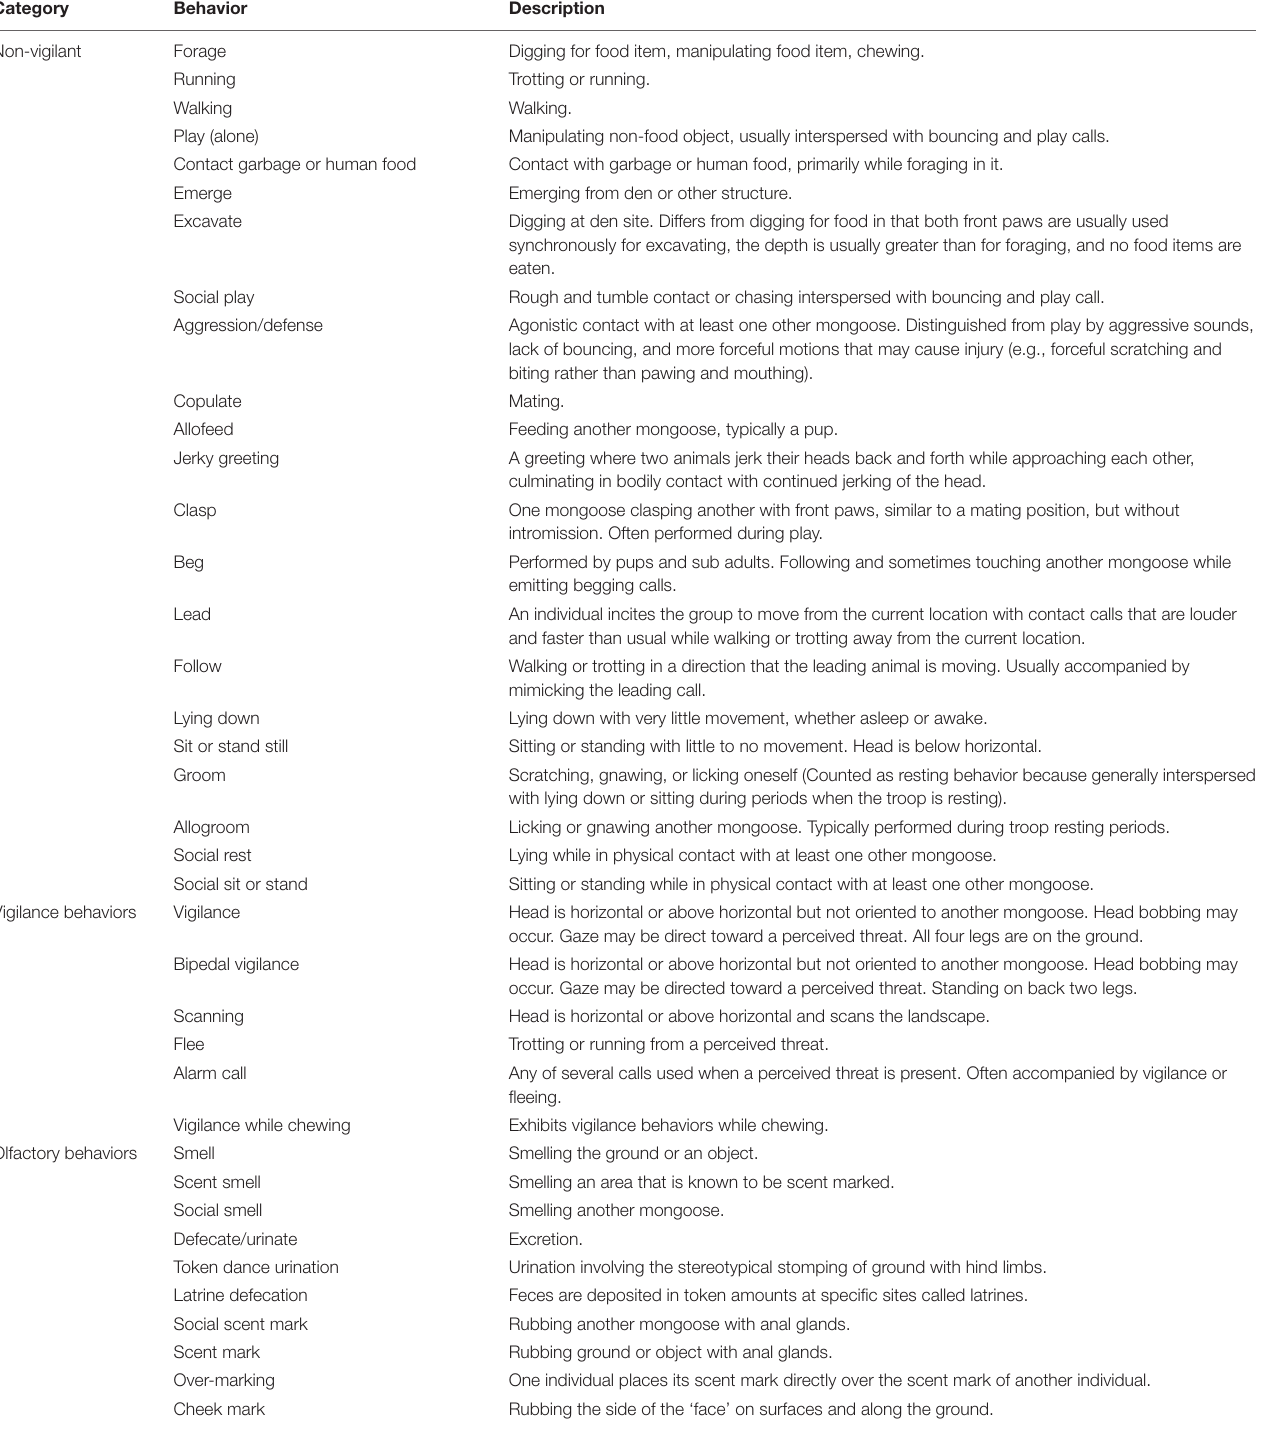
TABLE 1 | Ethogram for banded mongooses ( Mungos mungo ). Category Behavior